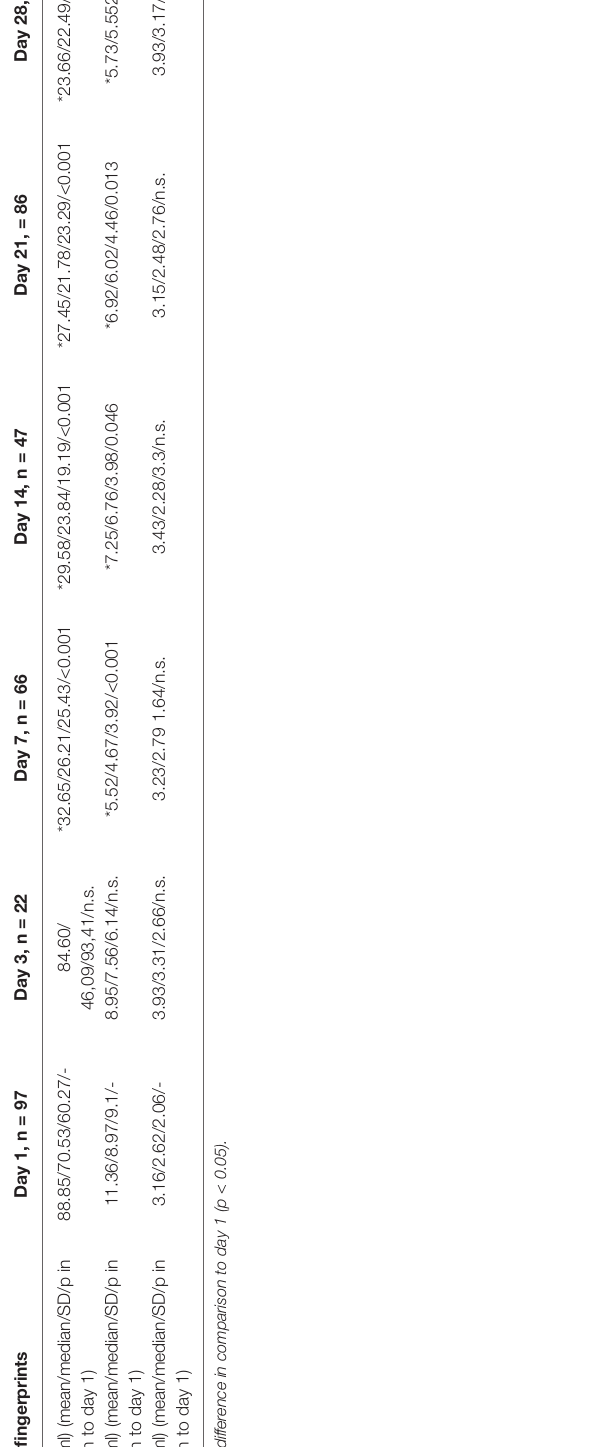
n = 86, birth weight: gal-1: R 2 = -0.21, P = 0.001, n = 86; gal-3: R 2 = -0.08, P = 0.007, n = 86). We found no correlation between gal-9 and gestational age or birth weight. In addition, SGA, gender, and multiple birth had no impact on gal-1, -3, or -9 serum concentration in our cohort.